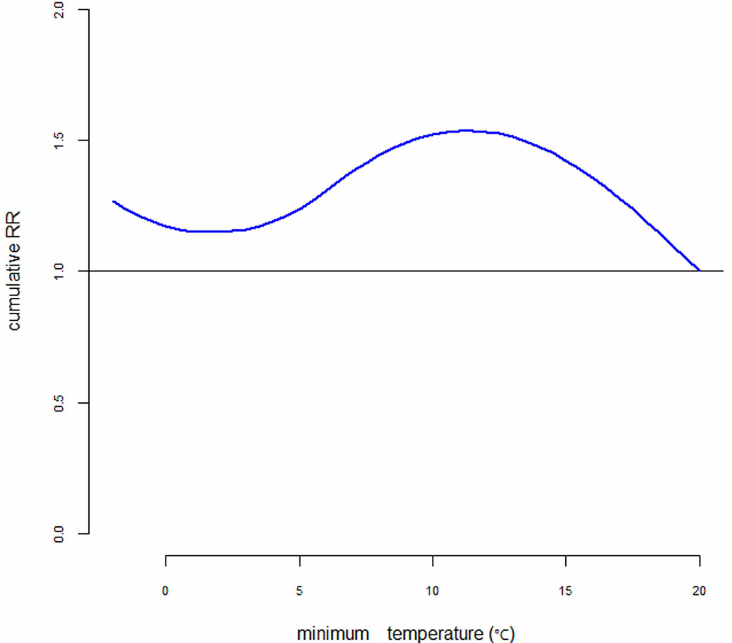
Fig 5. Cumulative relative risks of temperature on the RSV infection rateusing the DLNM model. Generally,the maximum impact of temperaturevariationon the detectionof RSV occurs at lag two day, the maximum RelativeRisk (RR) was approximately 1.5. The highestRR of RSV infectionoccurredat lag 1–2 days after the temperature decrease, and the RR increasedgraduallywith the temperature